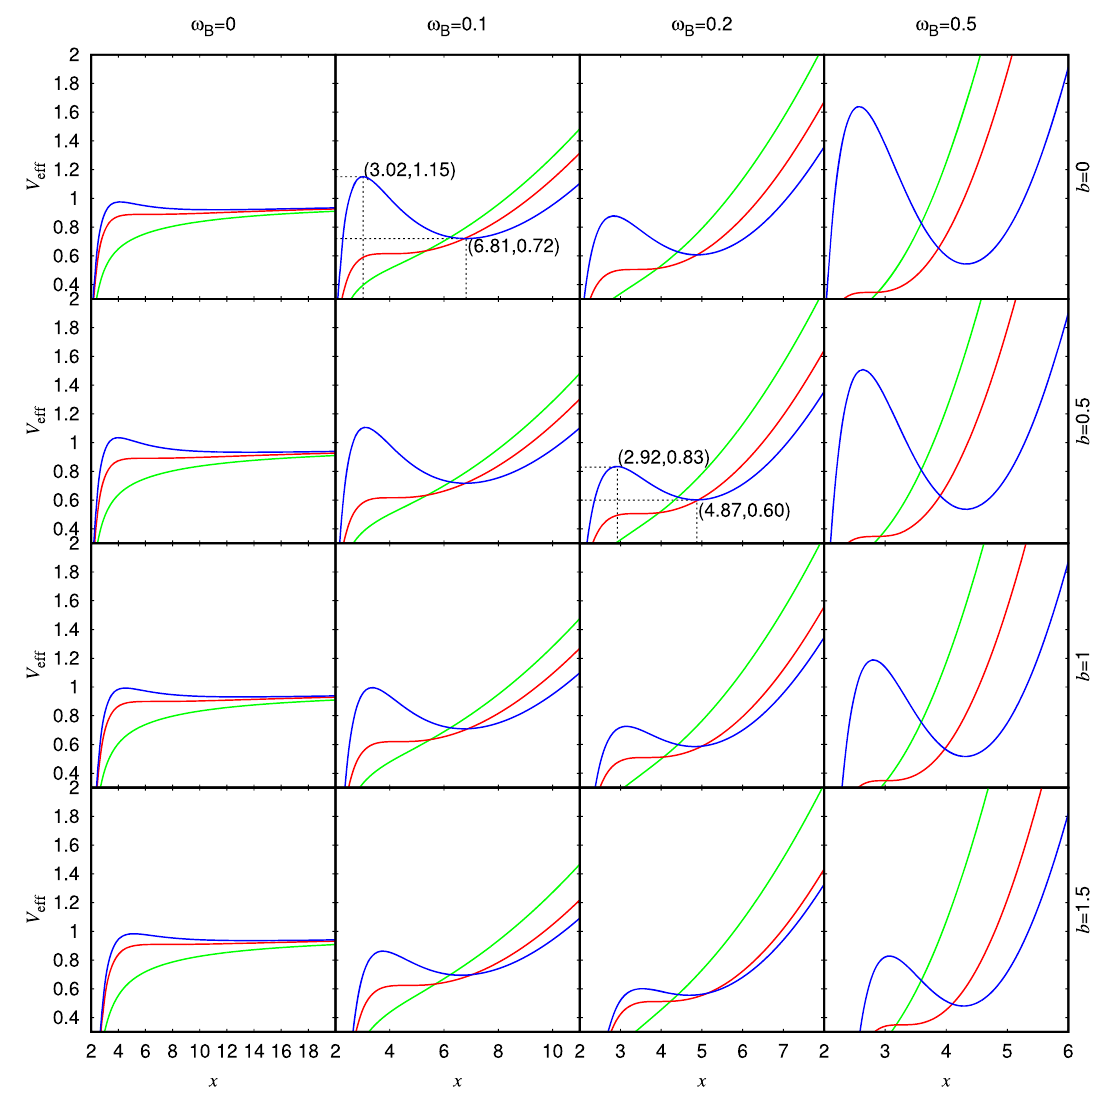
Fig. 5 The effective potential V eff for l > 0 as a function of x for charged test particles around quantum-corrected Schwarzschild black holes immersed in an external asymptotically uniform magnetic field